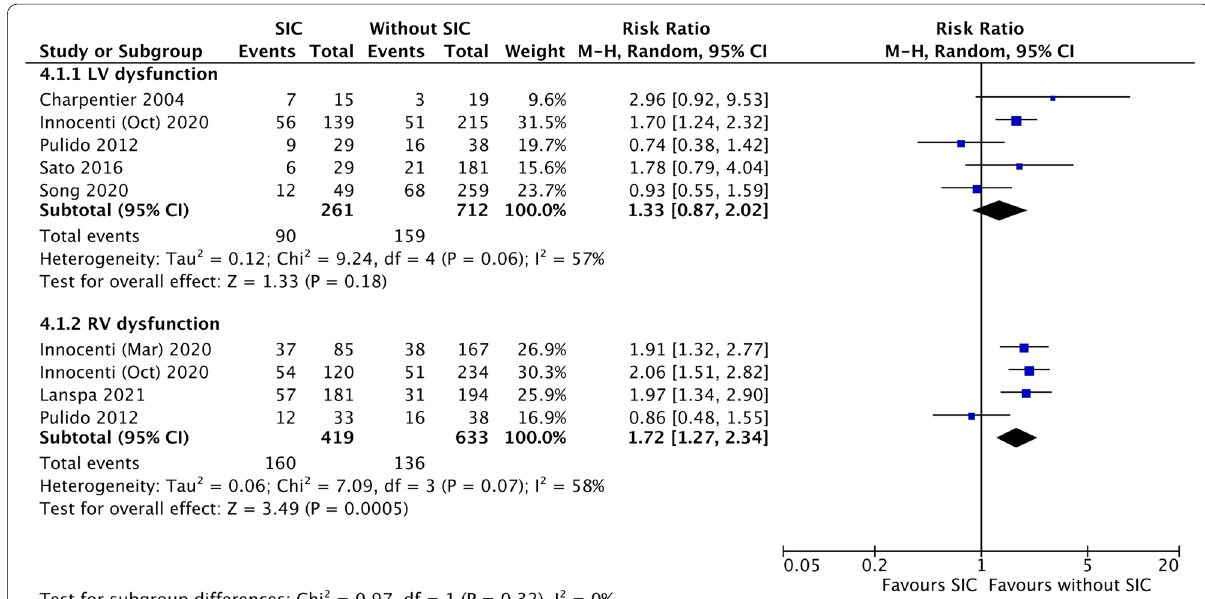
Fig. 5 The forest plot presents the subgroup‑analysis result stratifying one‑month mortality by left ventricular (LV) and right ventricular (RV) dysfunction. Sepsis‑induced cardiomyopathy (SIC) with RV dysfunction is significantly associated with higher risk of one‑month mortality (lower part), while the association between SIC with LV dysfunction and one‑month mortality is insignificant (upper